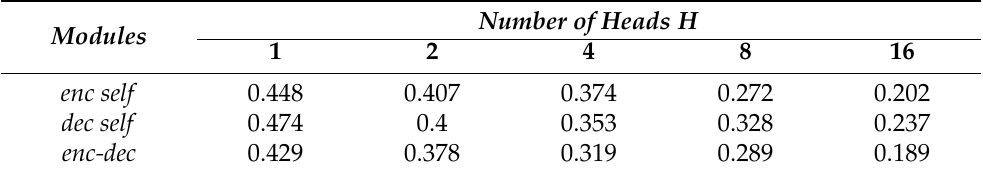
Table 2. SVCCA similarities versus a single headed model.